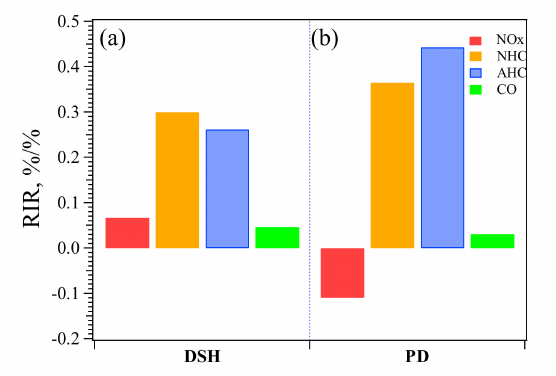
Figure 5. Average relative incremental reactivity ( RIR ) values of the O 3 precursors NO X , anthropogenic hydrocarbons (AHCs), biogenic hydrocarbons (NHCs), and CO at ( a ) the DSH site and ( b ) the PD site from 11–26 July.